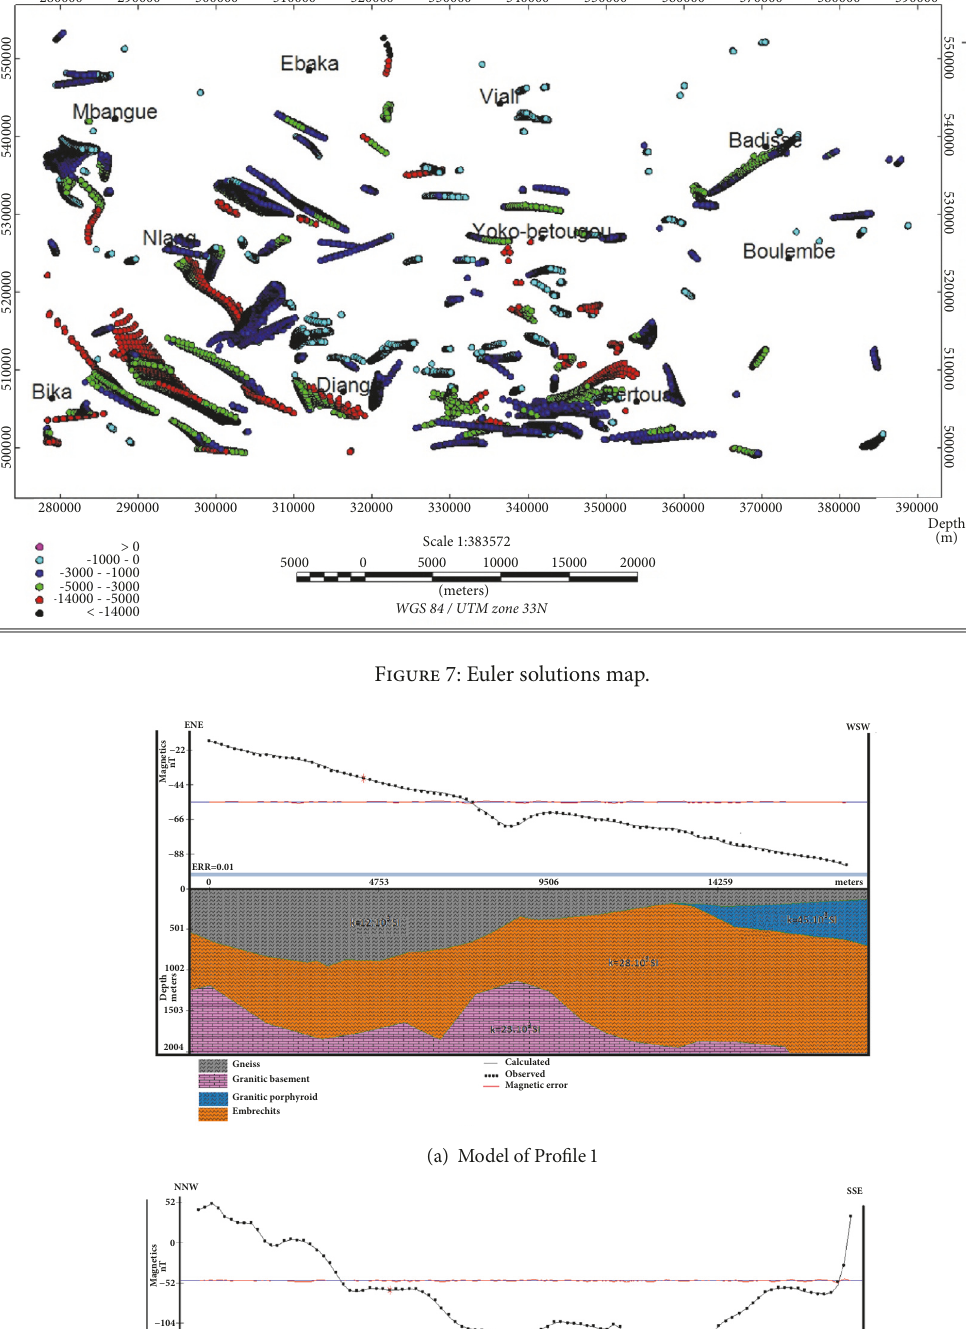
(a) Model of Profile 1